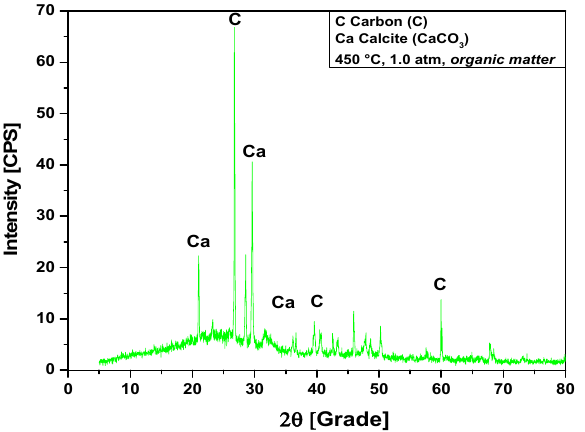
Figure 11. XRD of solid phase products by pyrolysis of (organic matter + paper) fraction of MHSW at 450 °C, 1.0 atm, using a borosilicate glass reactor of 125 mL, in laboratory scale. The XRD analysis of bio-char obtained by pyrolysis of (organic matter + paper) frac- tion of MHSW at 475 °C, 1.0 atmosphere, shown in Figure 12, identified the presence of two crystalline phase, CaCO 3 (Calcite) and graphite (C). The XRD shows the presence of four peaks associated with the crystalline phase CaCO 3 (Calcite), one of high intensity on the position 2 θ : 50.3 (100%), one of medium intensity on the position 2 θ : 69.2 (48.9%), and two of low intensity on the positions 2 θ : 21.1 (22.2%) and 2 θ : 29.6 (38.1%). One peak of high intensity is associated with the crystalline phase graphite, observed on the position 2 θ : 26.6 (100%).